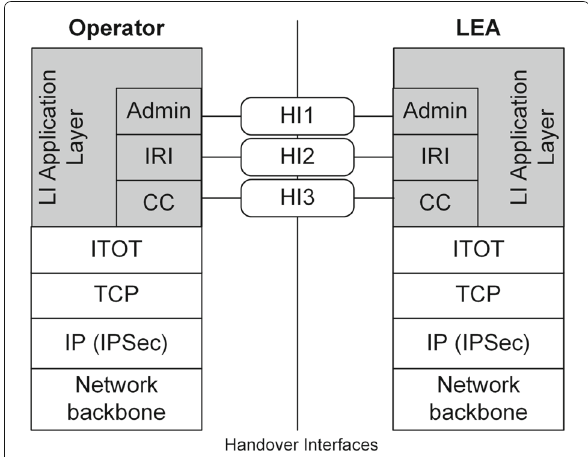
Fig. 2 The LI protocol stack. The encryption and authentication keys used on the LI application layer are negotiated during the forensic readiness phase between the operators and the LEA